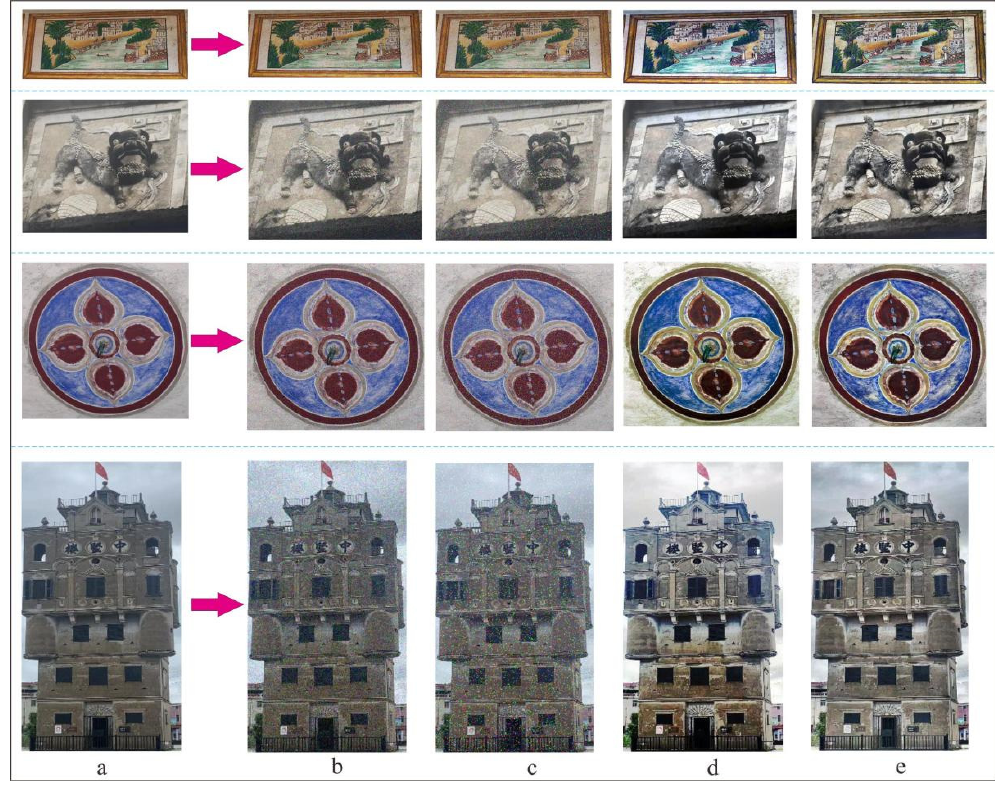
Figure 12. Image enhancement effect ( a ) original image, ( b ) gaussian noise, ( c ) salt and pepper noise, ( d ) histogram equalization, ( e ) restricted contrast adaptive histogram equalization.